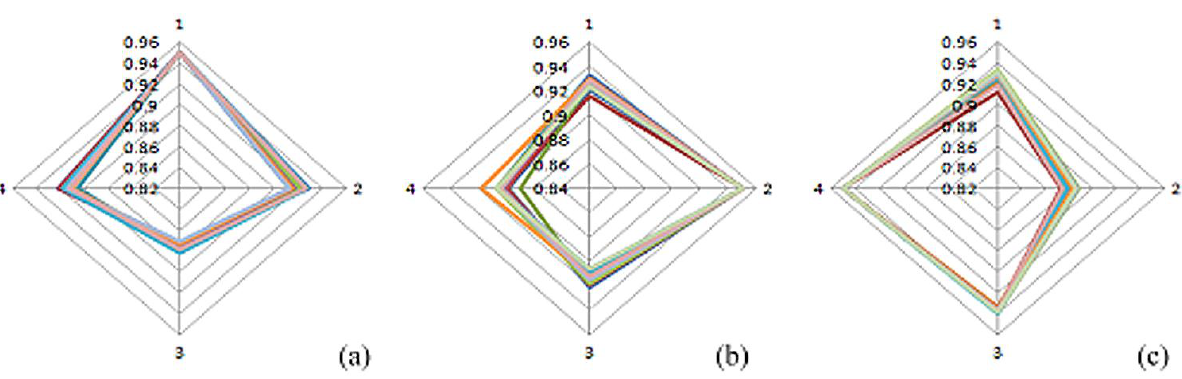
Figure 9. Fruit pattern of ( a ) banana; ( b ) lemon; and ( c ) lychee